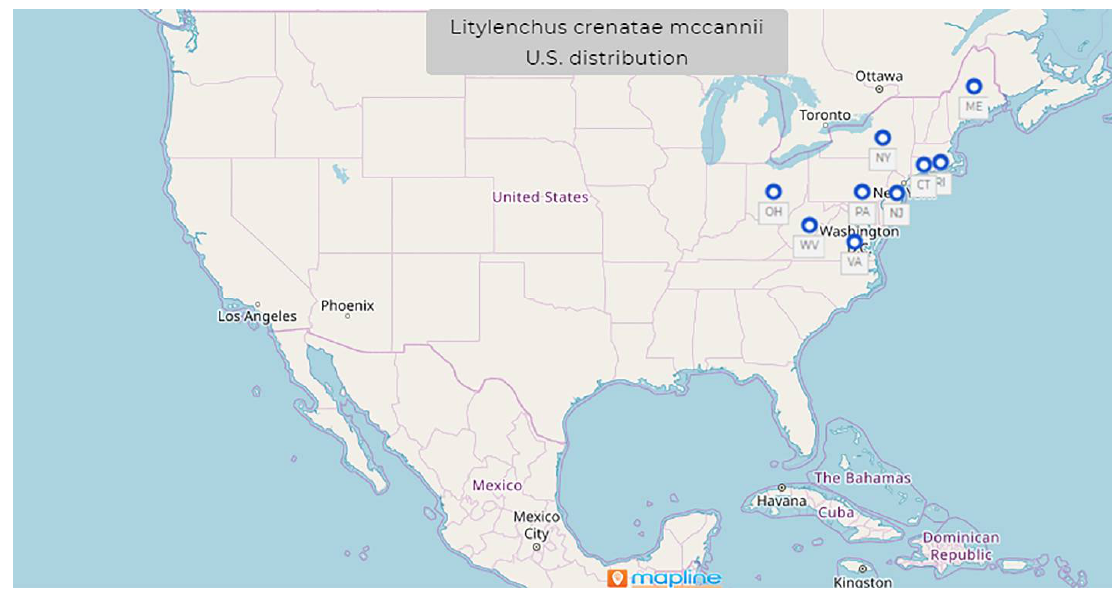
Figure 9. Continental U.S. distribution map of Litylenchus crenatae mccannii ssp. Molecular characterization: Ribosomal DNA marker sequences of Litylenchus crenatae mccannii ssp. were nearly identical to the population of Litylenchus crenatae from Japan [19]. The internal transcribed spacer (ITS) rDNA and 18 S rDNA sequences for Litylenchus crenatae from Japan are 99.7% and 99.9% similar, respectively, to Litylenchus crenatae mccannii from North America. Pathogenicity: Since first reported in U.S. in 2012, this nematode species spread very rapidly through several states in the Northeast U.S., and the latest report of this species from 2021 is approximately 300 miles south from the earliest report from WV [21]. High levels of infection with this nematode in overstory beech trees have been observed. The mortality of infected understory beech trees has been reported after several years of dis- ease [103,104]. This species is not yet a regulated pest in the U.S. However, it is considered an emerging and a highly virulent species that could cause great problems to North Amer- ican forest ecosystems. Diagnosis: Morphologically and molecularly, the closest species is Litylenchus crenatae . However, young females of Litylenchus crenatae mccannii ssp. population can be differen- tiated from the Litylenchus crenatae by having (i) longer stylets 9.7 ± 0.9 (8.6–11.2) vs. 8.0 ± 0.4 (7.4–8.5) µm; (ii) longer stylet conus 4.6 (3.6–5.2) vs. 3.1 (2.8–3.5) µm; and (iii) shorter pharynx (152.6 ± 16.2 vs. 203 ± 5.9 µm). In mature females, a shorter post- uterine sac (36.9 ± 9.4 vs. 68 ± 7.4 µm) was noted in the Litylenchus crenatae mccannii specimens. Shorter tail in the fixed immature female populations (48.3 ± 6.2 vs. 55 ± 3.8 µm) but longer in the mature populations (43.7 ± 11.3 vs. 33 ± 2.3 µm). This caused differences in the c (16.8 ± 1.4 vs. 24.5 ± 1.9) and c’ (5.3 ± 1.2 vs. 2.9 ± 0.3) ratios. Narrower body width in mature females in all populations (16.2 ± 2.4 vs. 22.9 ± 2.6 µm) were noted. Some differences between the male specimens from North America and the Japan populations were recorded: (i) longer stylet (11.2 (10.6–12) vs. 10.2 (9.9–11)) µm and stylet conus (4.8 (4.4–5.3) vs. 3.6 (3.5–4.3)) µm; (ii) wider body (16.7 (13.5–20.3)) µm than the fixed type population from Japan [19].